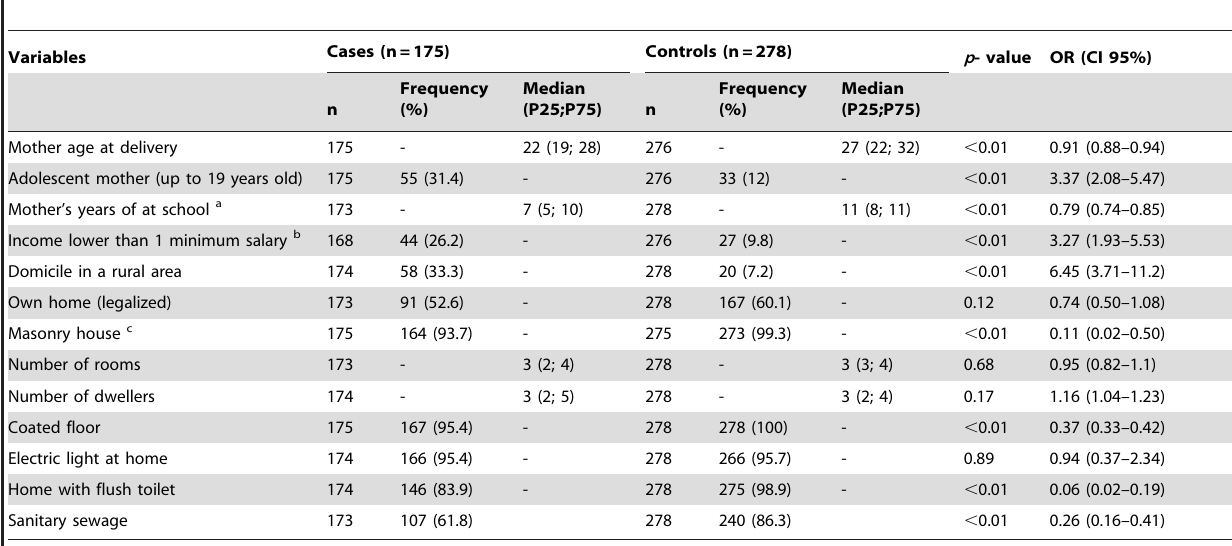
Table 1. Univariate analysis of demographic and socioeconomic characteristics of mothers of children with congenital toxoplasmosis and their controls identified in the scope of the newborn screening program in the State of Minas Gerais.